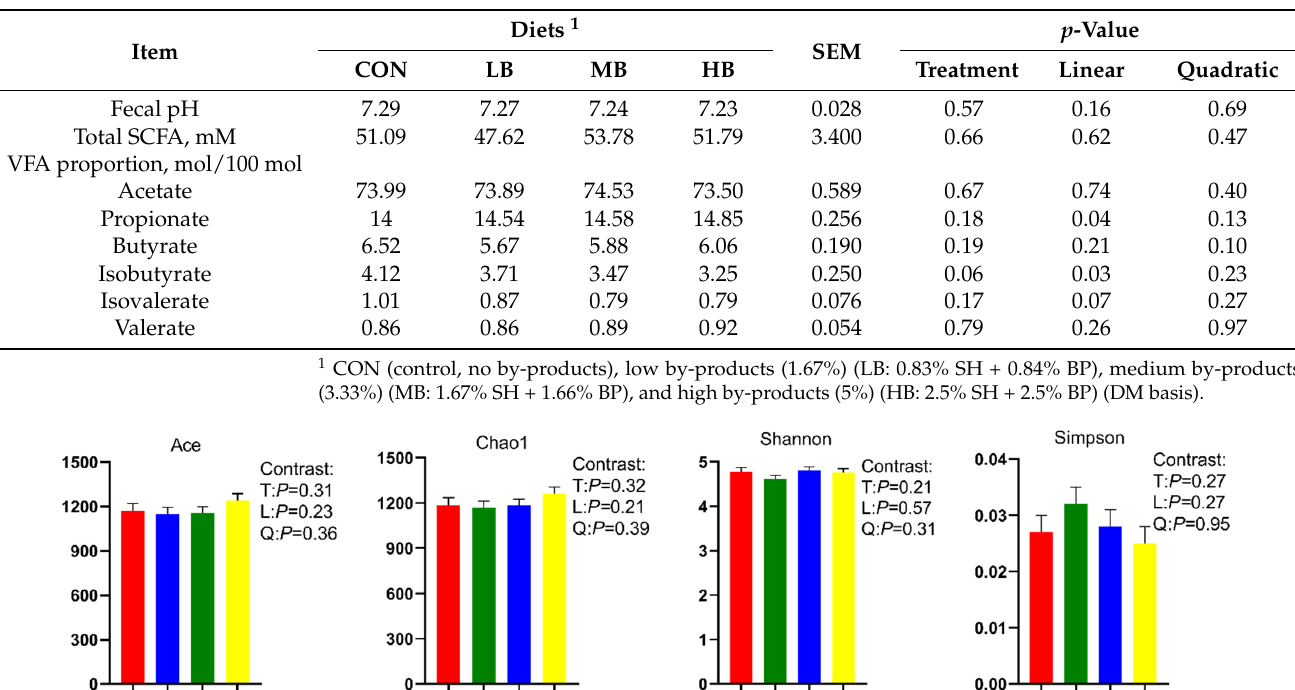
Table 2. Fecal short-chain fatty acid (SCFA) profile of lactating Holstein cows fed diets with by-products substituted for forage.